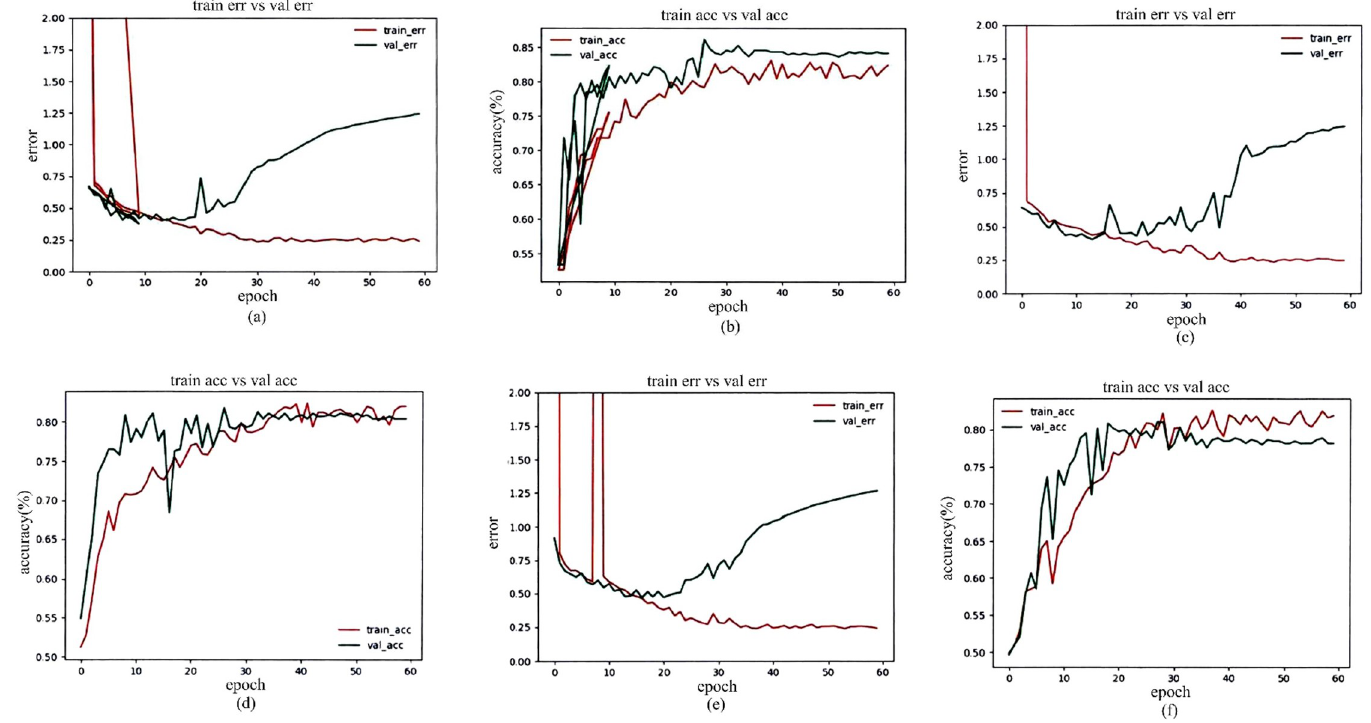
https://doi.org/10.1371/journal.pone.0235672.g009